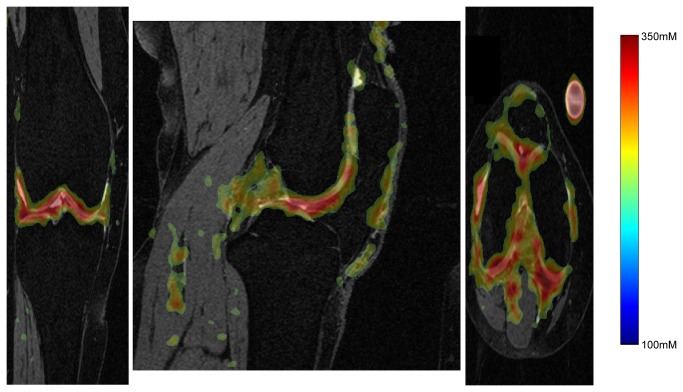
Example 3D sodium concentration dataset overlaid on the 3D DESS image.High values of sodium concentration can be found co-localized with the articular cartilage.